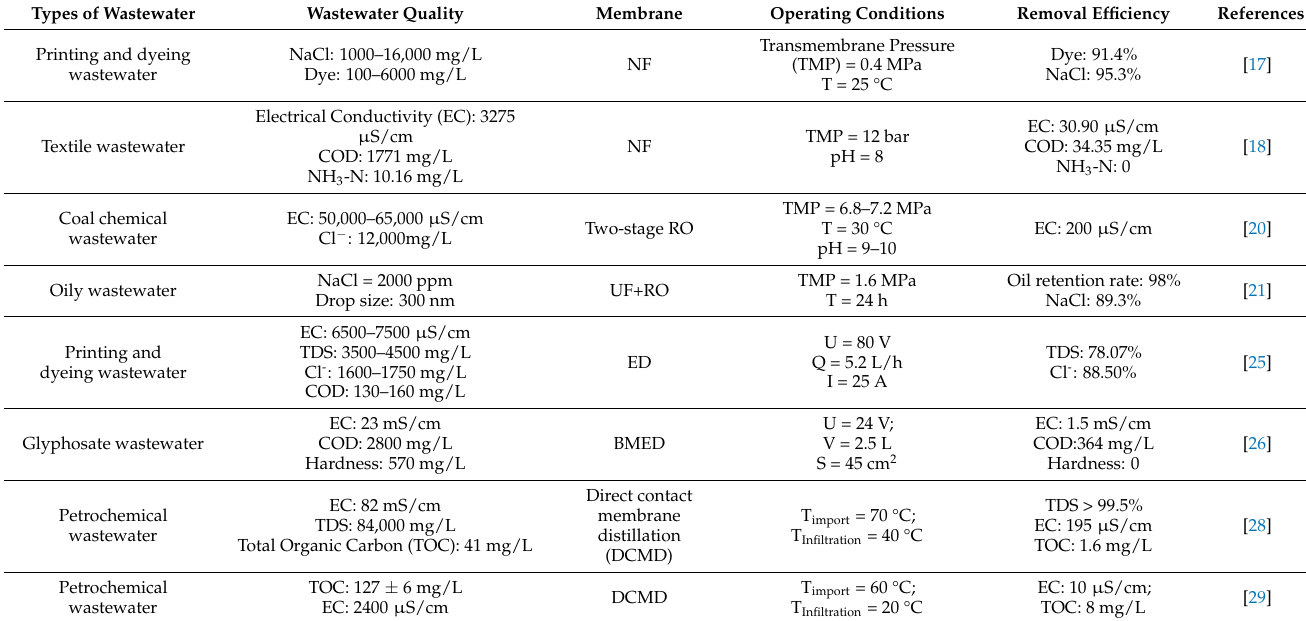
Table 2. Performance and experimental conditions of membrane filtration techniques for the treat- ment of saline